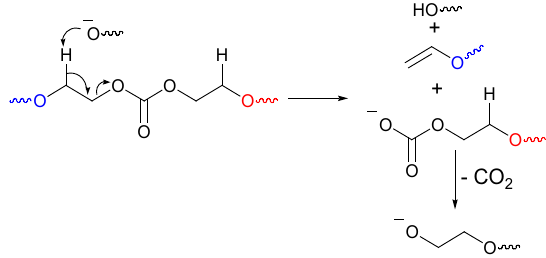
Figure 6. Decarboxylation mechanism (backbiting) of a polycarbonate [37].